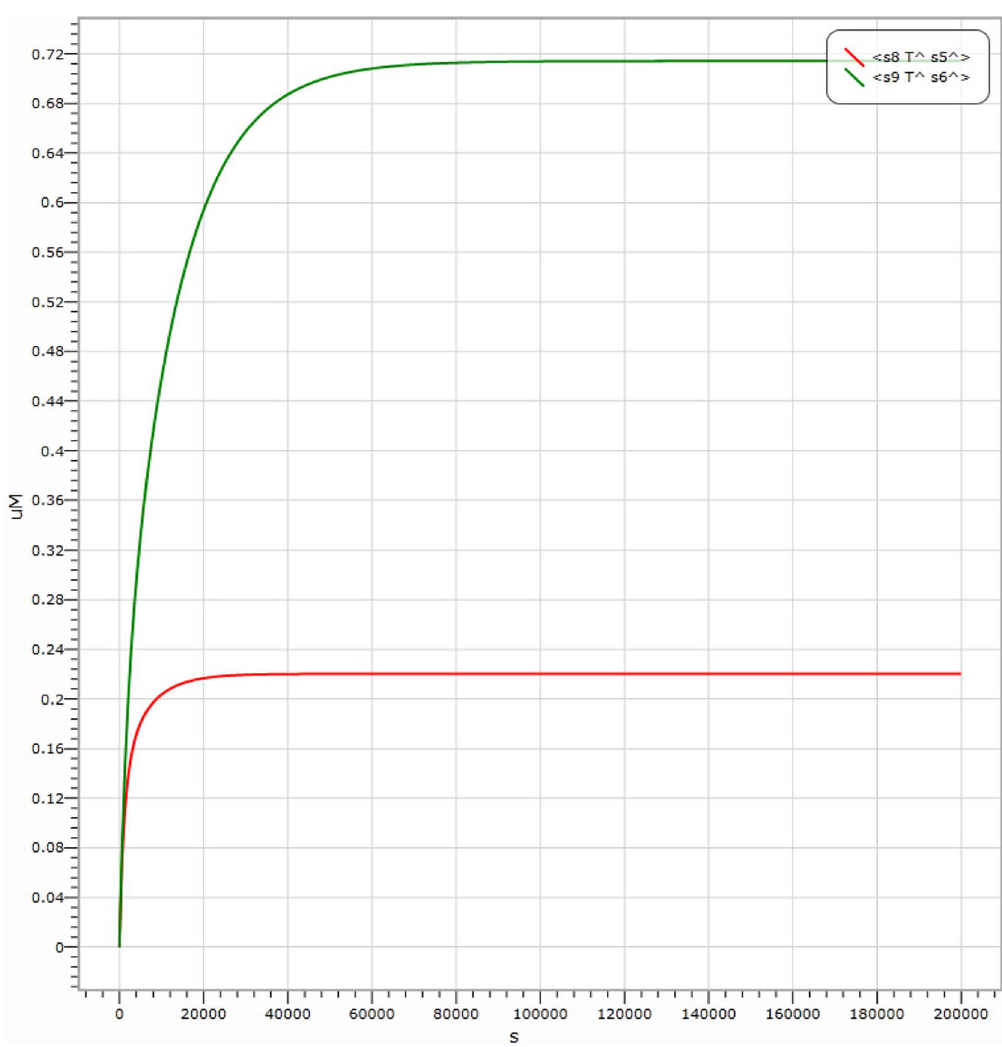
Figure 7. Visual DSD simulations of AND logic gate with input signal ‘‘01’’.